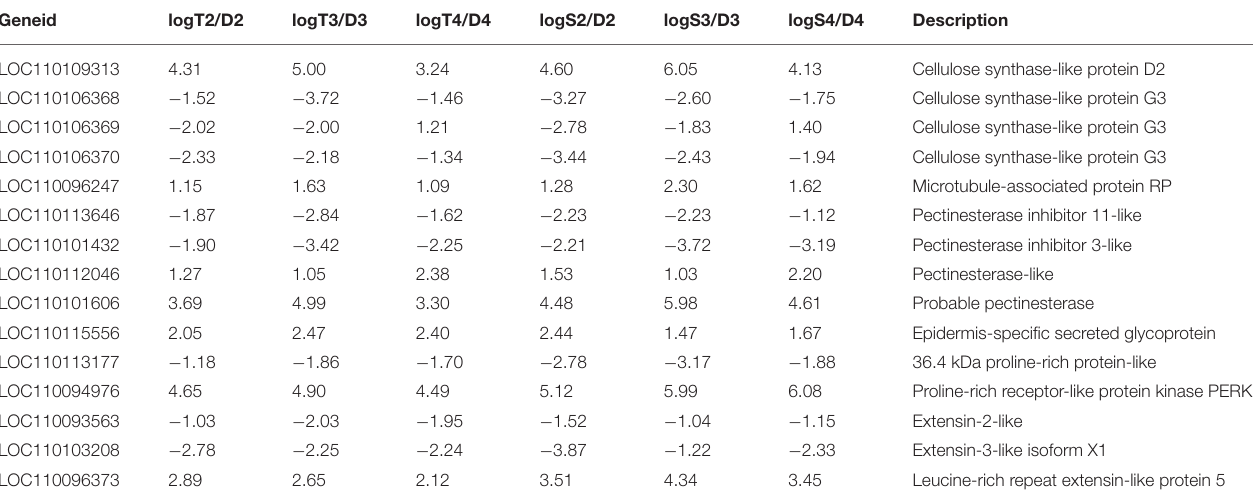
TABLE 2 | Fifteen differentially expression plant genes involved in cell wall composition and remodeling during D. officinale symbiotic germination. Geneid logT2/D2 logT3/D3 logT4/D4 logS2/D2